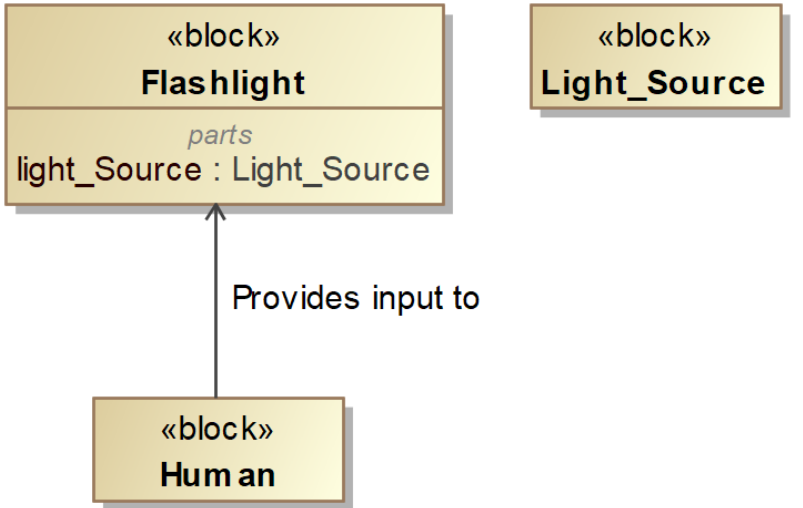
Figure 2. A representation of the use of SysML that will later be used to describe the metamodel of Wymore’s T3SD. The vertical arrow moving from the Flashlight block to the Human block is a directed association. This relationship is read as the Human “provides input to” the Flashlight.